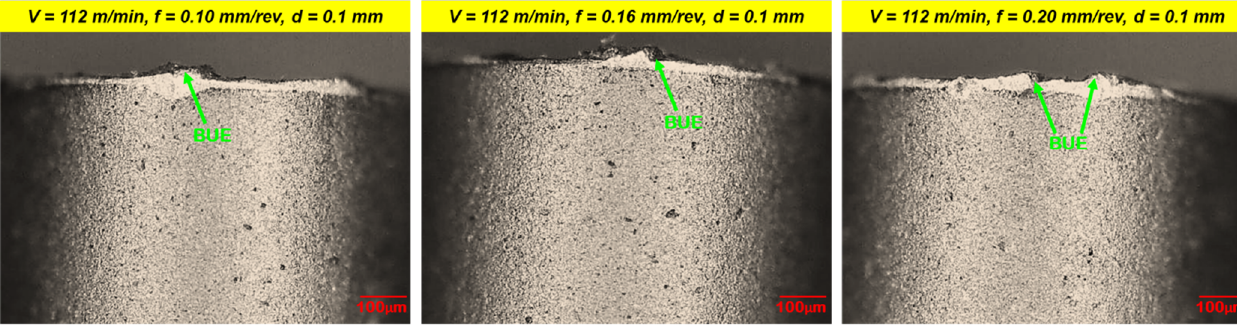
Figure 9. SEM images of a worn-out insert illustrating built-up-edge (BUE) formation.